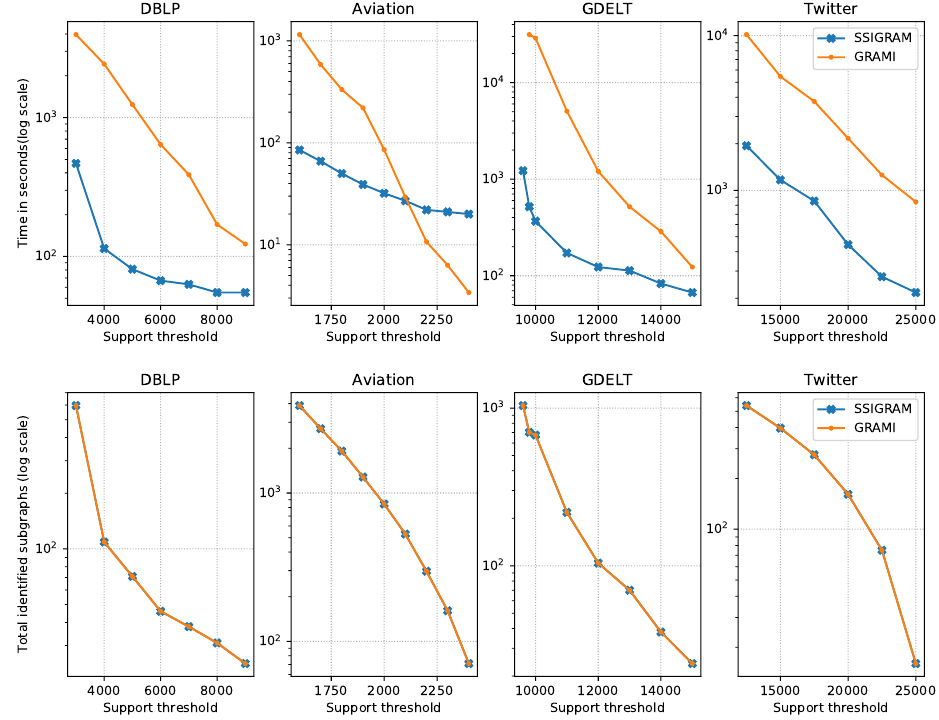
Figure 7. Performance of SS I G RA M and G RA M I on the four different datasets. Abbreviations: DBLP (DataBase systems and Logic Programming), GDELT (Global Data on Events, Location and